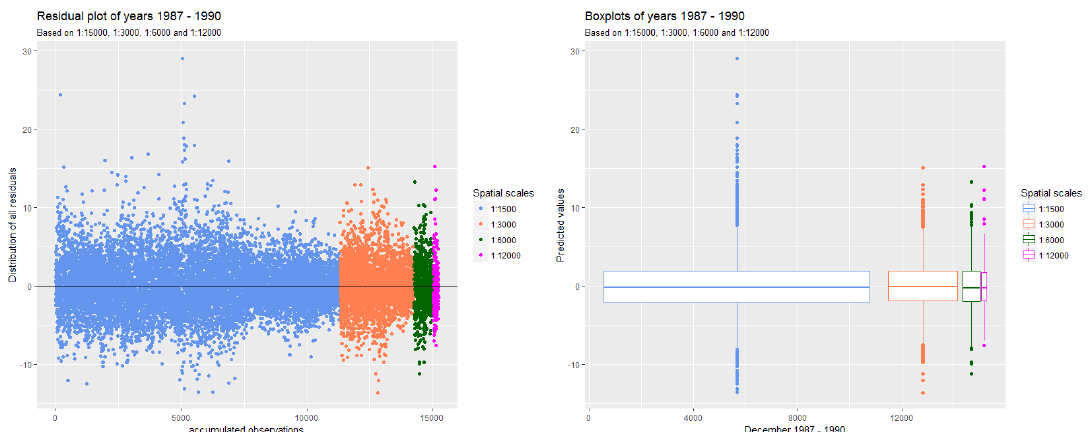
Figure 11. Deviation of residuals in all resolutions combined in one plot ( left ) and corresponding box plots ( right ).